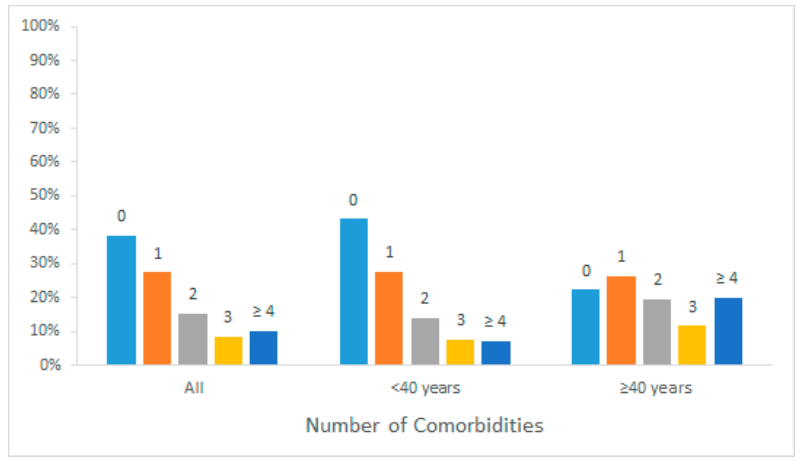
Figure 1. Number of comorbidities according to age group.